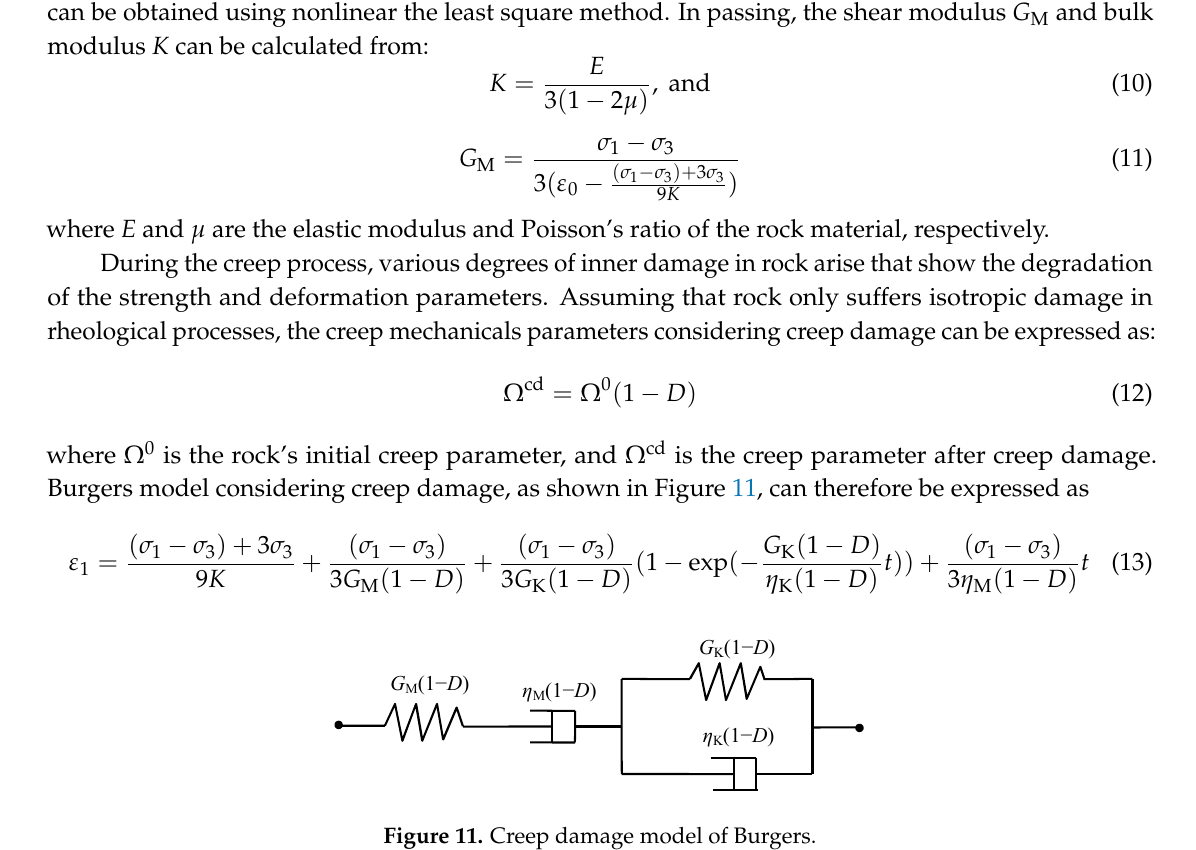
Figure 11. Creep damage model of Burgers.